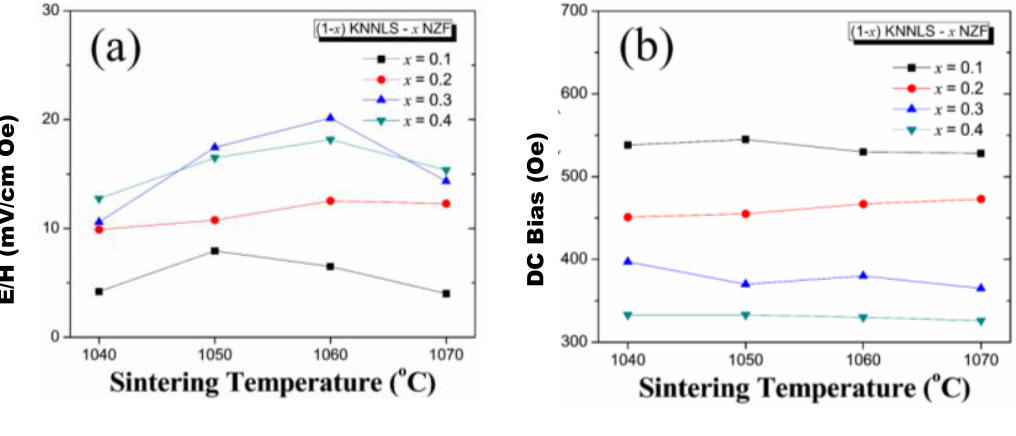
for (1 − x) KNNLS–x NZF composites. bias